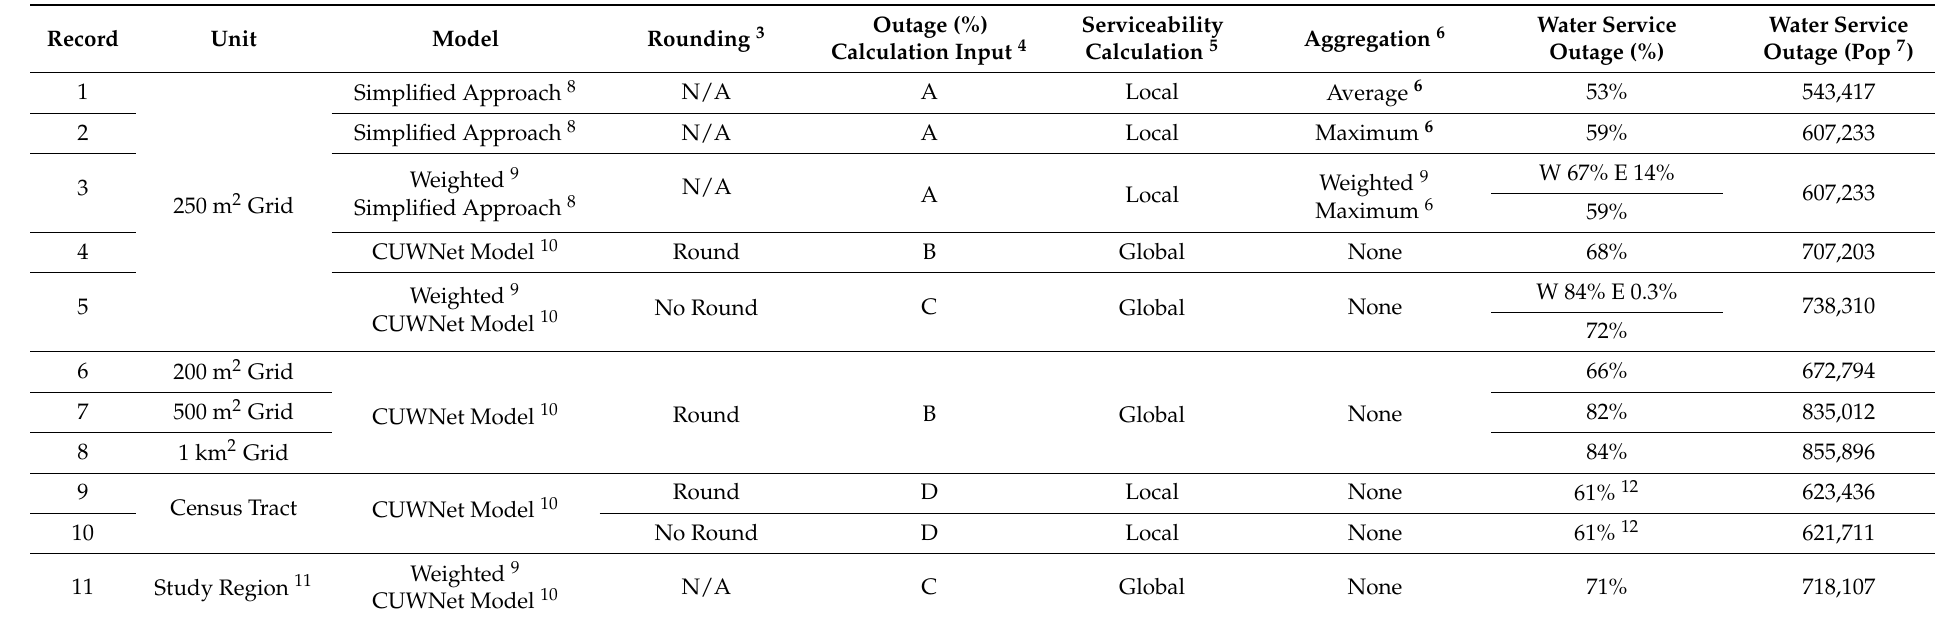
Table 1. Sensitivity analysis results for application of the serviceability index from CUWNet model results 1